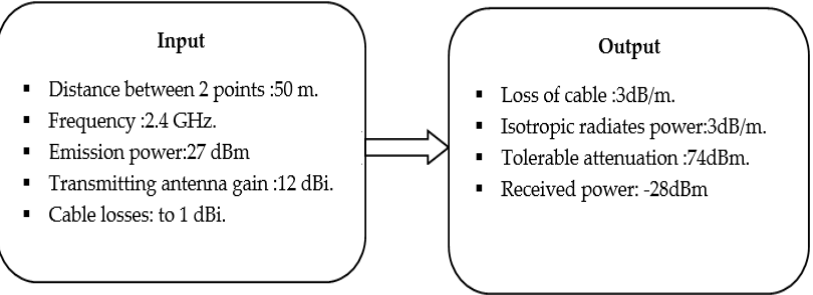
Figure 3. Input–output data of the MATLAB calculator interface.